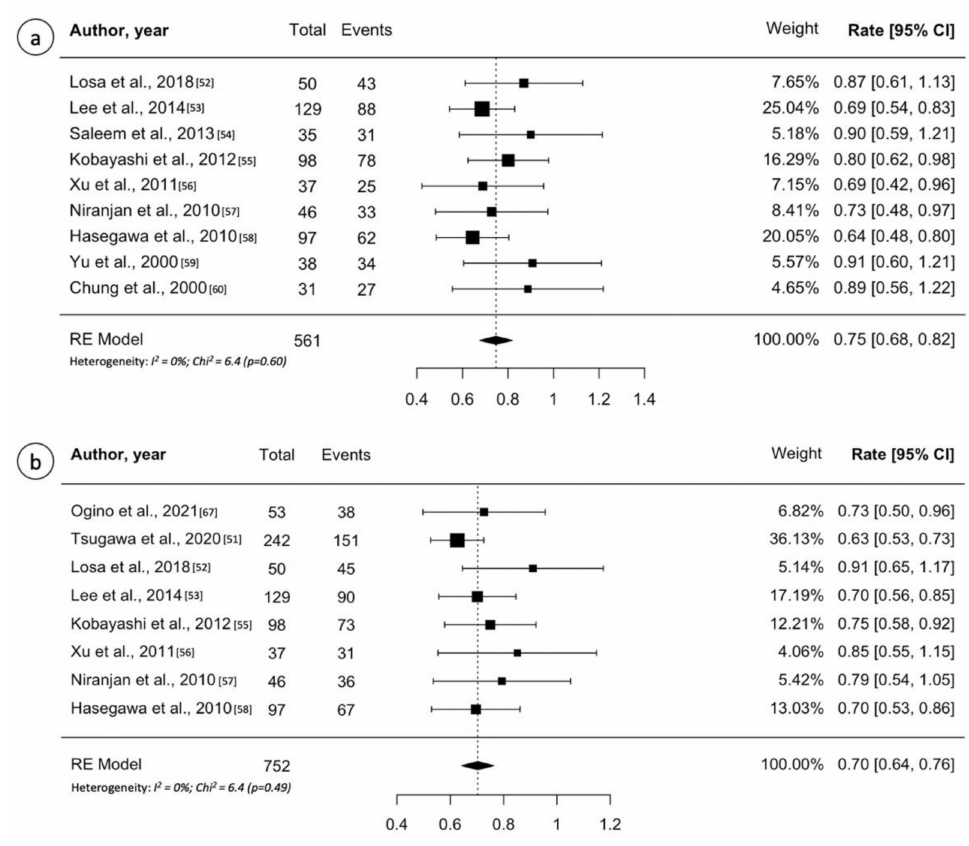
Figure 6. ( a ) Forest plot of overall tumor control following Gamma Knife treatment for cranio- pharyngioma; ( b ) Forest plot of 5-year recurrence-free survival after Gamma Knife treatment for craniopharyngioma. Random effects models pooled estimates are presented and heterogeneity analysis are